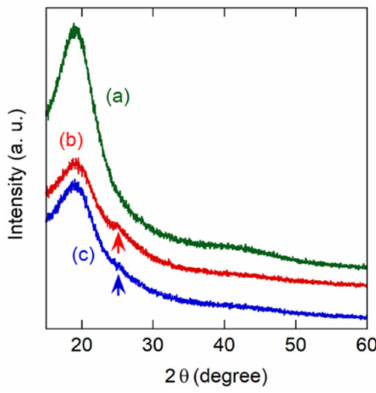
Figure 2. XRD patterns of ( a ) PSt(4.1) microspheres, ( b ) PSt@PANI(2.5) microspheres, and ( c ) PSt@PANI(4.5)